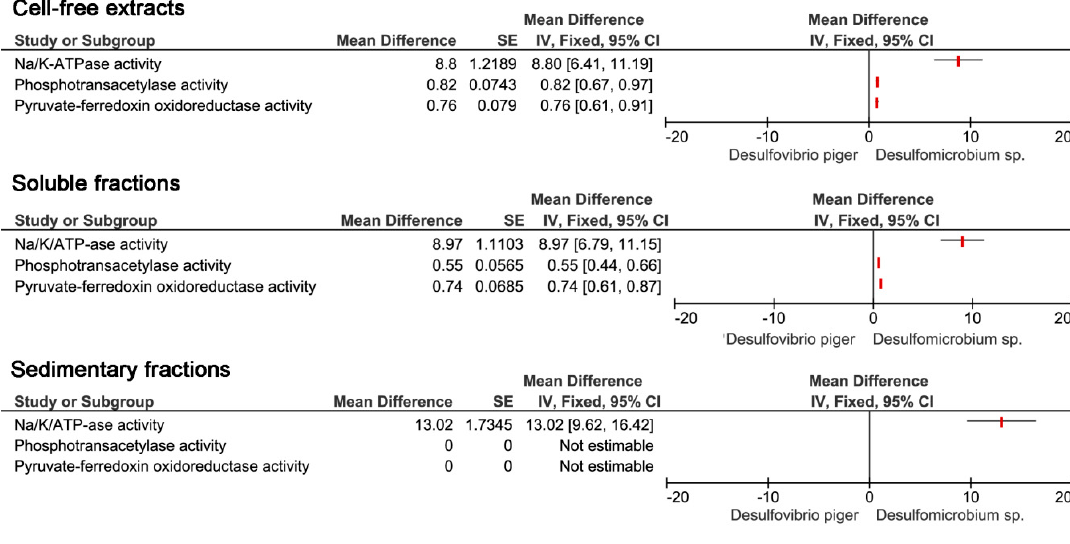
Figure 6. Enzyme activity in Desulfovibrio and Desulfomicrobium .